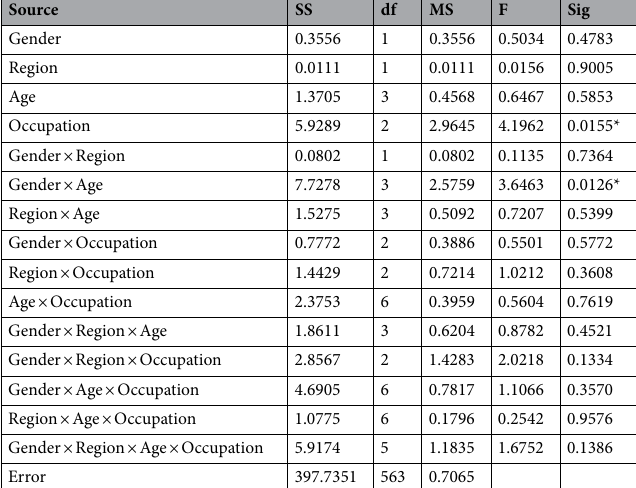
Table 5. Four-way analysis of variance of optimistic bias with gender, region, age and occupation. * p <